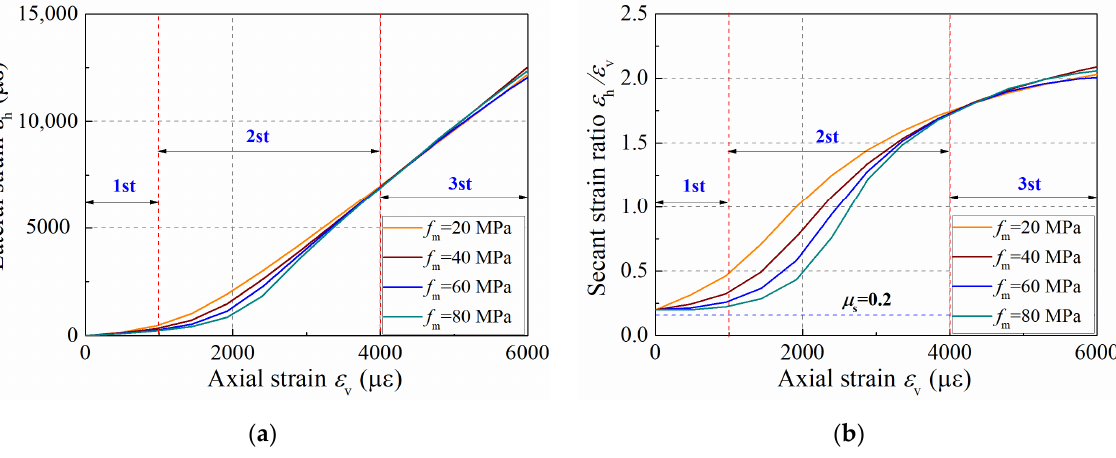
Figure 10. Dilation behavior of concrete in radial direction: ( a ) ε h – ε v curve; ( b ) μ s – ε v curve.